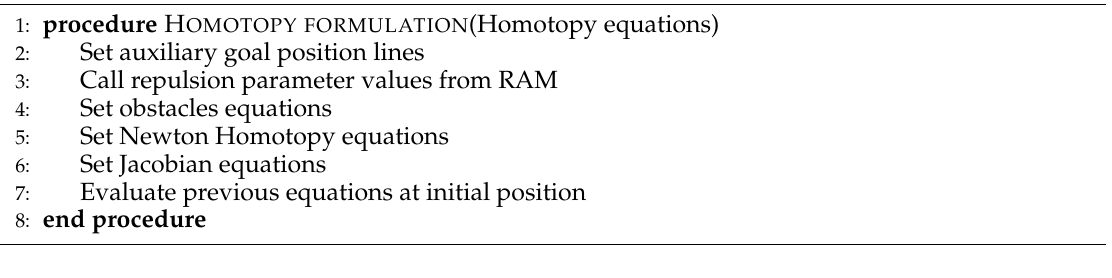
Algorithm 7 Homotopy Path Planning